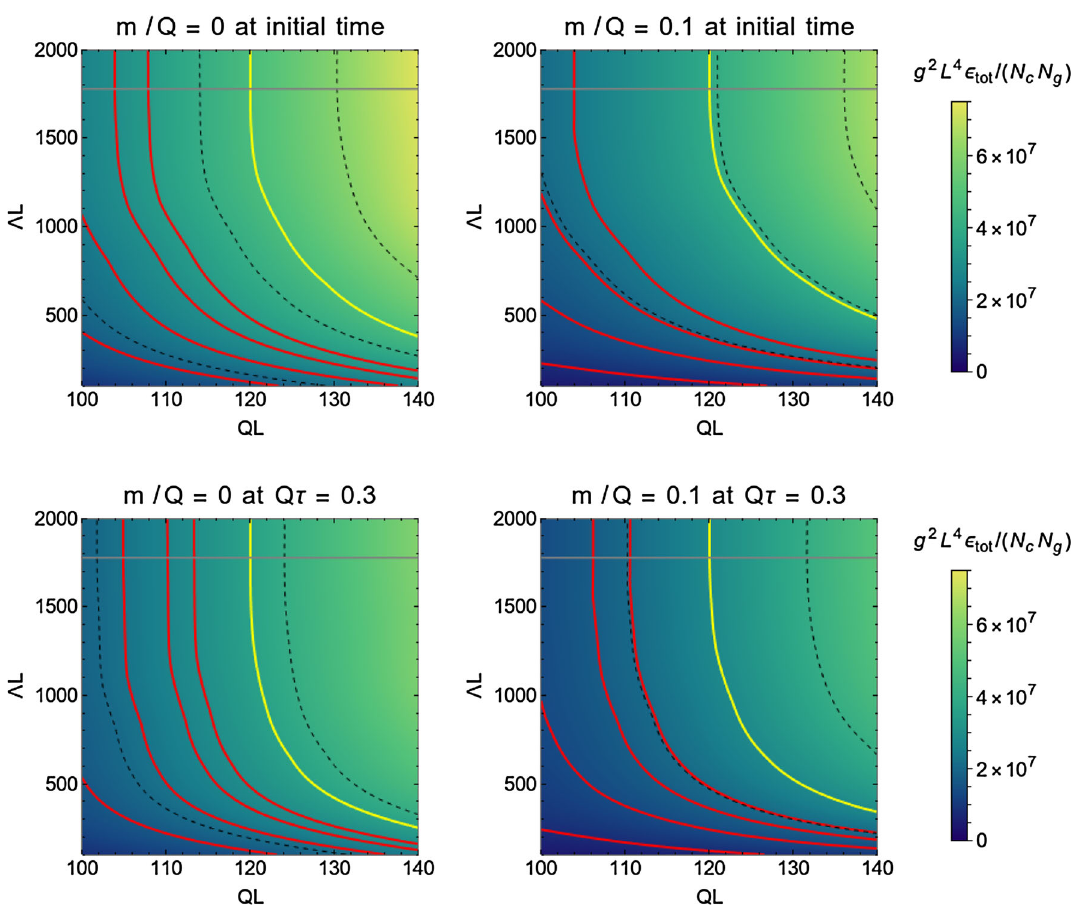
Fig. 12 SU(2) total energy density on a 400 2 lattice with N l = 30 as a function of QL and Λ L at initial time and at Q τ = 0 . 3. The dashed linesrepresentconstantenergydensitylevelsatintegermultiplesof10 8 . The red solid lines indicate the constant energy densities corresponding to Λ ∈ { Q , 2 Q , 3 Q , 4 Q } at QL = 120. The yellow solid line refers to